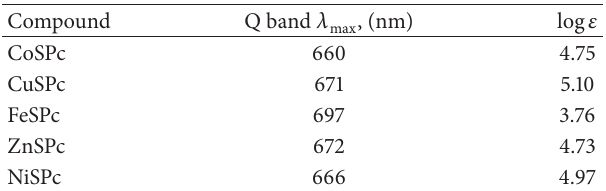
Table 2: Absorption spectral data for sulfonated phthalocyanine metals in DMF ( 𝑐 = 2 × 10 −5